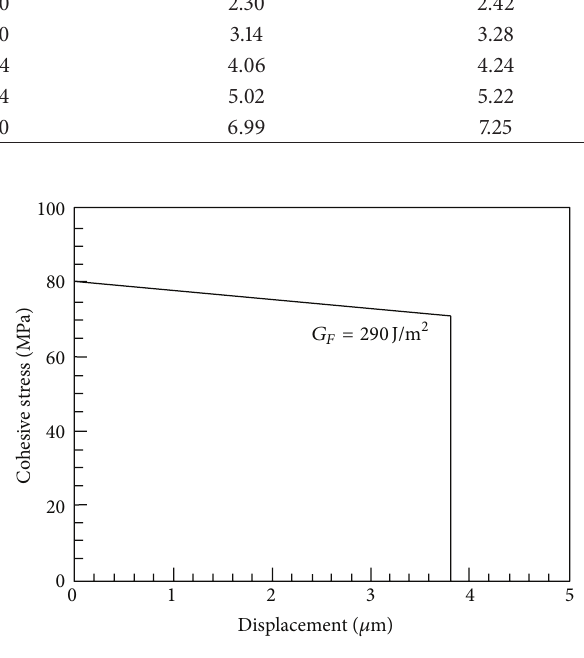
Figure 4: Typical softening function for